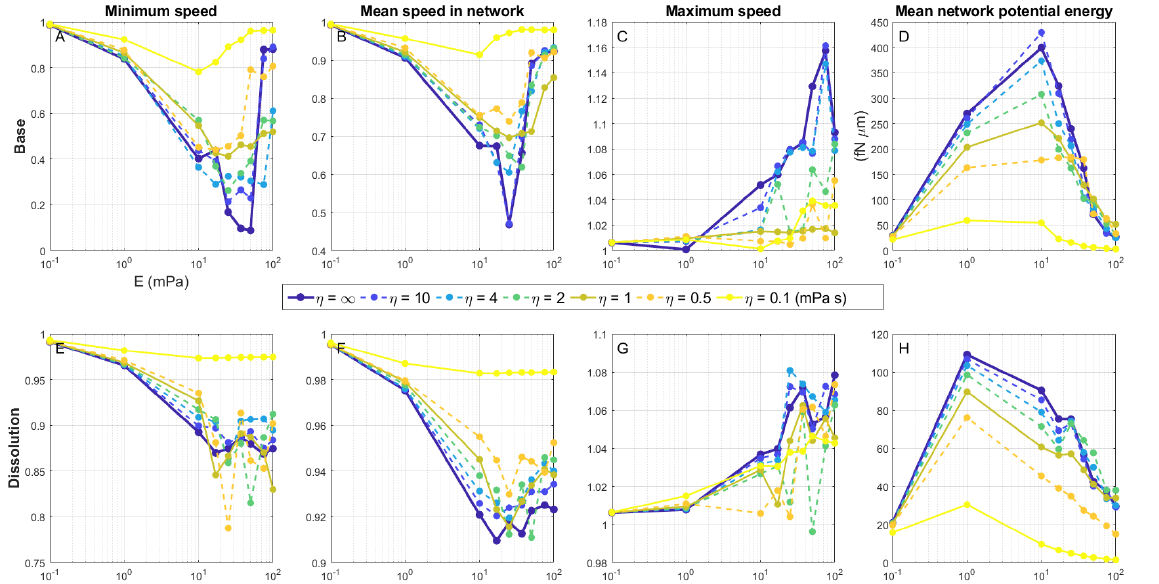
Figure 9. Summary metrics for simulation results across a range of E and η , for base case without remodeling ( A – D ) versus with chemical dissolution ( E – H ). Minimum and maximum swimming speed over the entire simulation, and mean swimming speed and network potential energy averaged up to the time at which the center of the body reaches the right edge of the network. All speeds are normalized to that of the Newtonian ( E = 0) case. Note the different y-axis scales between some base and dissolution panels for